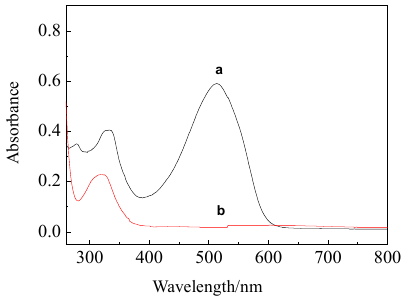
Figure 7 . IR spectra of Sr the solid sample after degrading reaction (b) and Acid Red